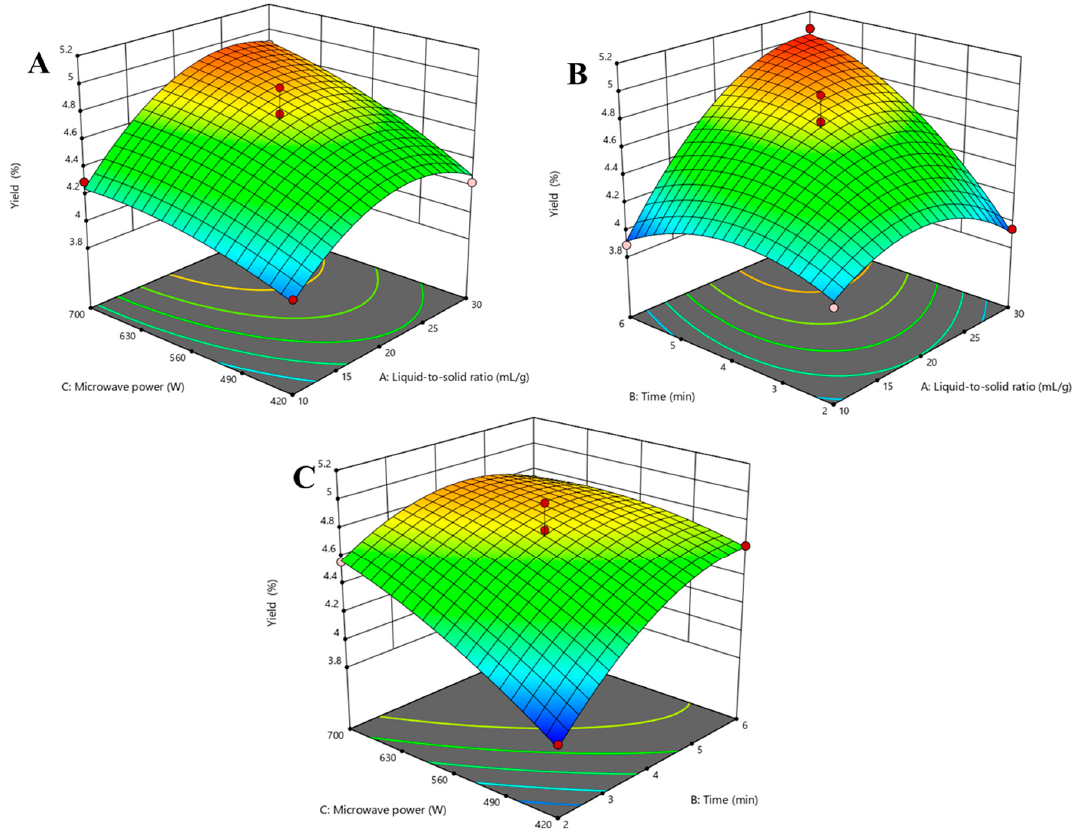
Figure 2. Response plots of the effects of various factors on the yield of EO. ( A ) is the graph of interaction between the liquid-to-solid ratio and microwave power; ( B ) is the graph of interaction between the liquid-to-solid ratio and time; ( C ) is the graph of interaction between l microwave power, and